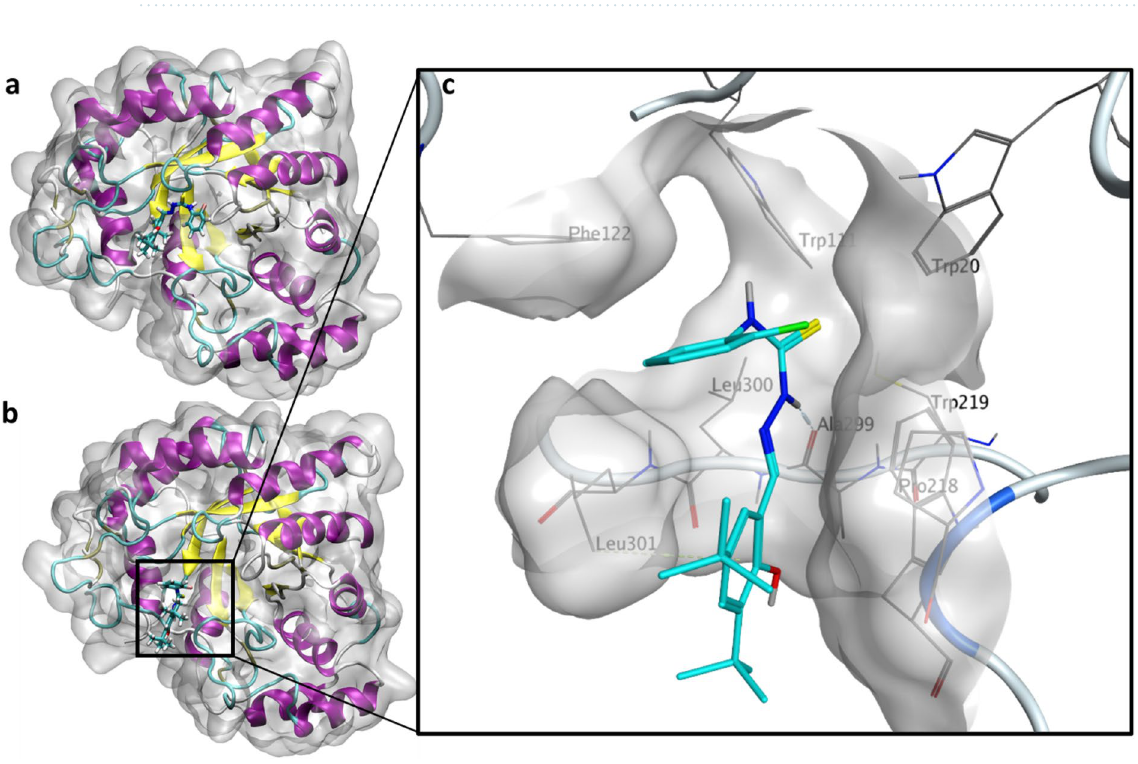
Figure 5. Simulated poses of 3m inside ALR2. ( a ) Initial docked pose of 3m inside ALR2. ( b ) Snapshot of 3m at the 50 ns timepoint. ( c ) Interactions of 3m with the ALR2